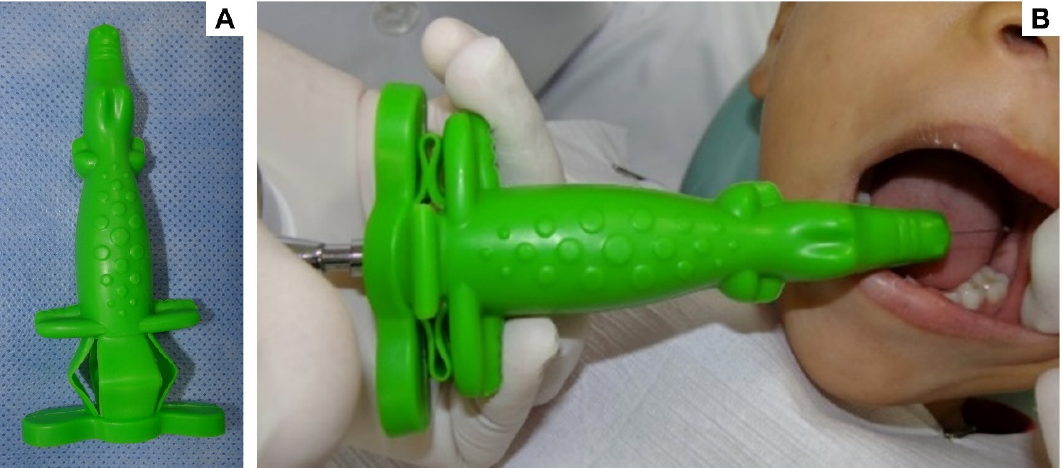
Figure 1 . Local anesthesia was performed with a visual passive distraction crocodile case device for carpule (Angie by Angelus ® , Londrina, PR, Brazil). In ( A ), note the crocodile case for carpule (Angie by Angelus ® , Londrina, PR, Brazil), and in ( B ), the local anesthesia performed.